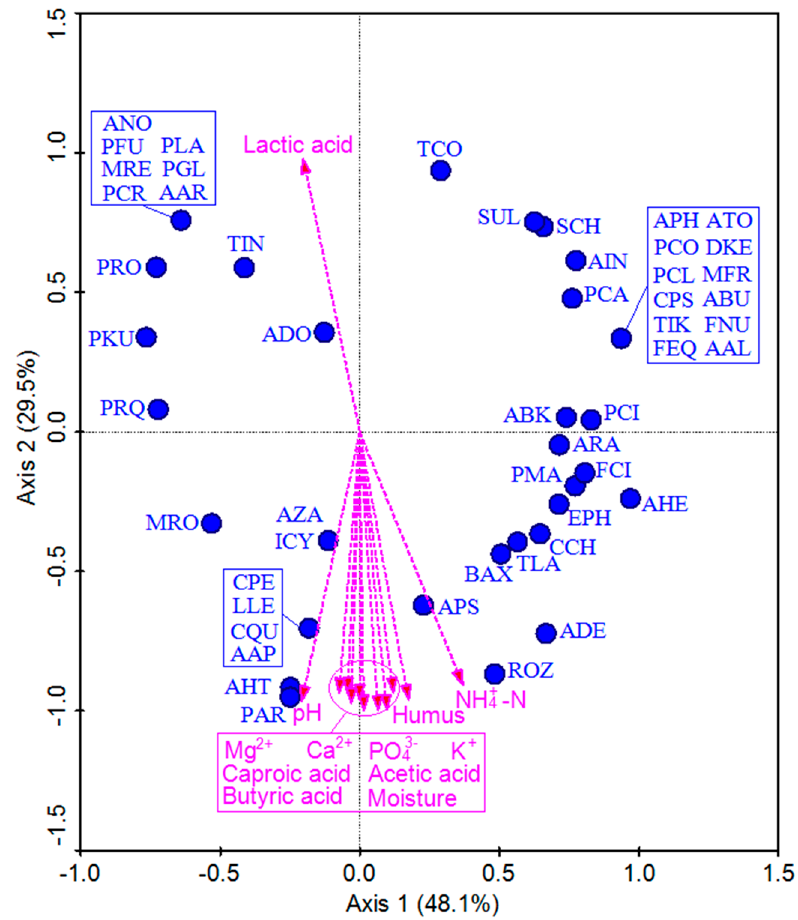
Figure 5. Redundancy analysis of fungal communities and physico-chemical attributes. The arrows indicate the direction and magnitude of biogeochemical attributes associated with fungal commu-